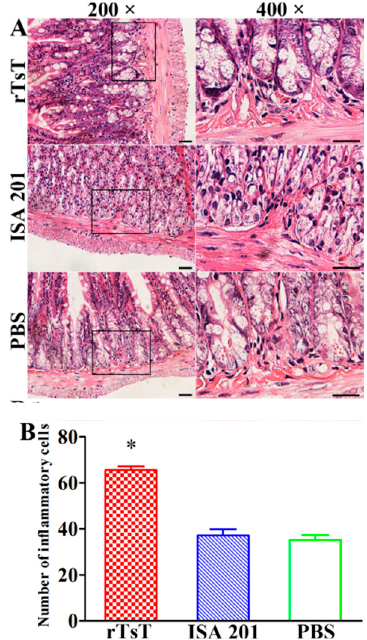
Figure 14. Intestinal histopathological change of infected mice at 5 days after challenge. The intestinal